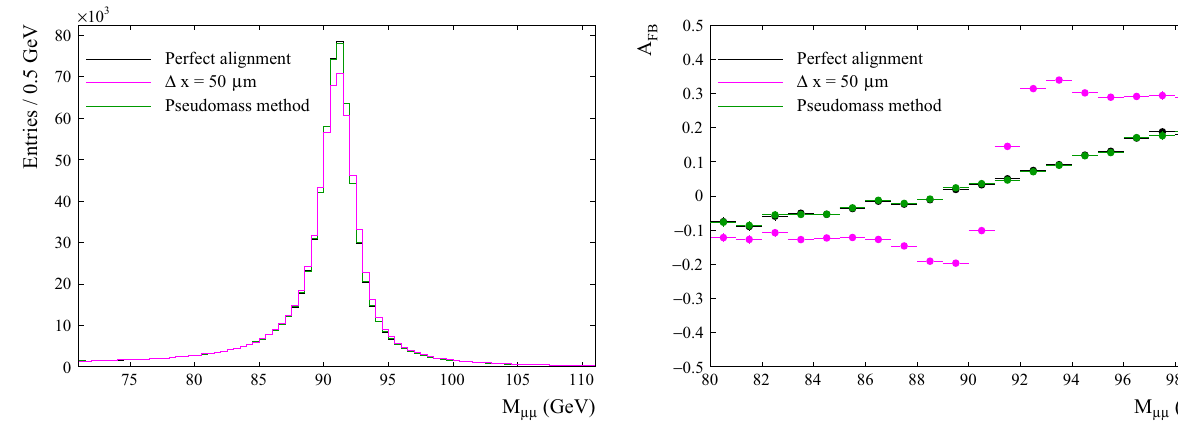
Fig. 5 The pseudomass correction in bins of [ η,φ ] for (clockwise from upper left) a coherent Δ x = 50 μ m, coherent Δ z = 100 μ m, incoherent Δ x = Gaus ( 0 , 100 ) μ m, coherent R = 0 . 2mrad z